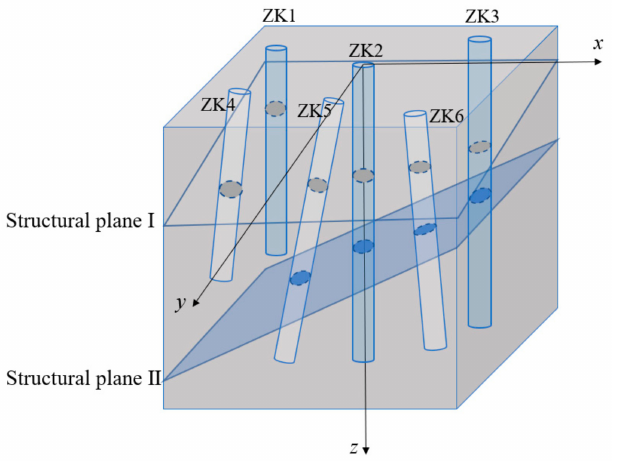
Figure 7. Structural plane and borehole arrangement